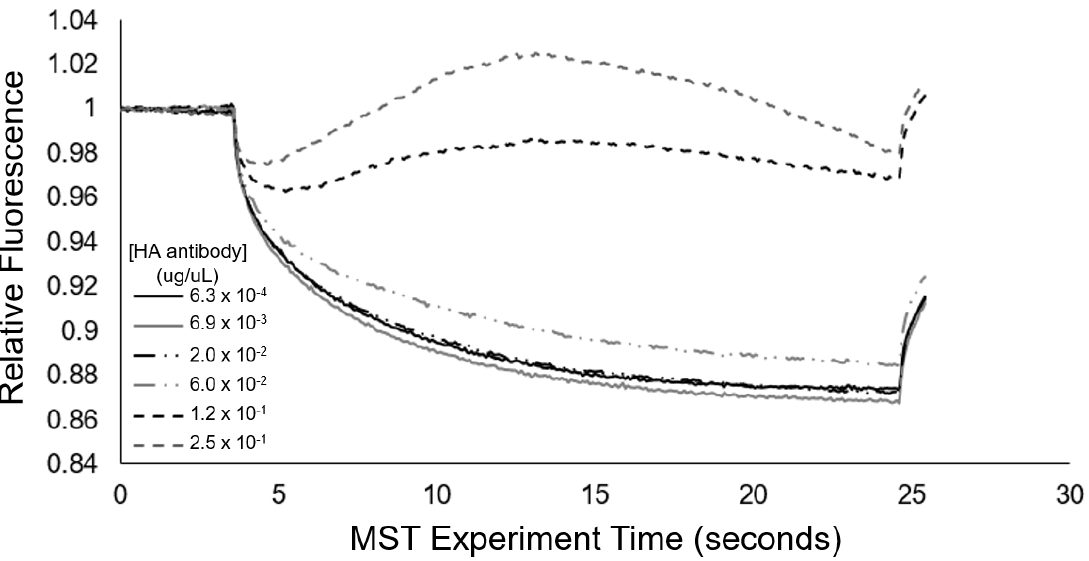
Figure 7. Microscale thermophoresis of 0.01% HA epitope-displaying vesicles (pre-heated to exhibit red fluorescence) mixed with concentrations of anti-HA antibody from 250 ng/uL to 0.63